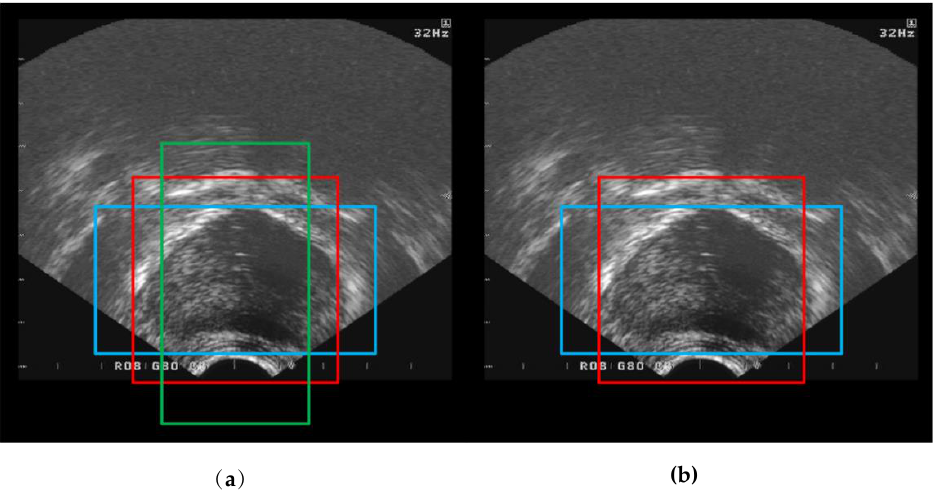
Figure 4. ( a ) The original Anchor mechanism ( b ) The modified Anchor mechanism.